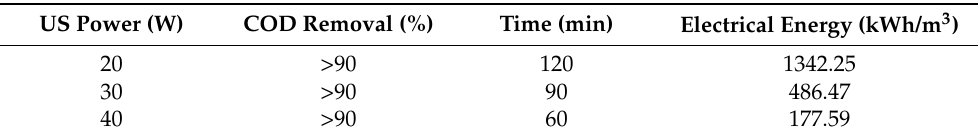
Table 4. Comparison of the electrical energy consumption by different US power for >90%